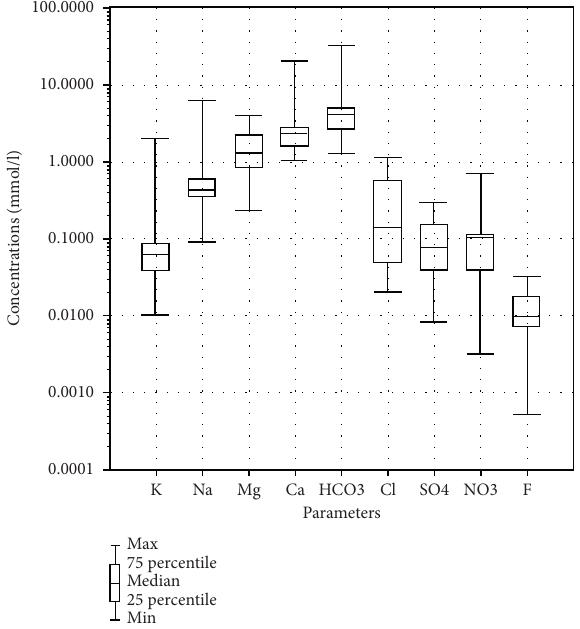
Figure 17: Box and whisker diagram represents the hydrogeochemical